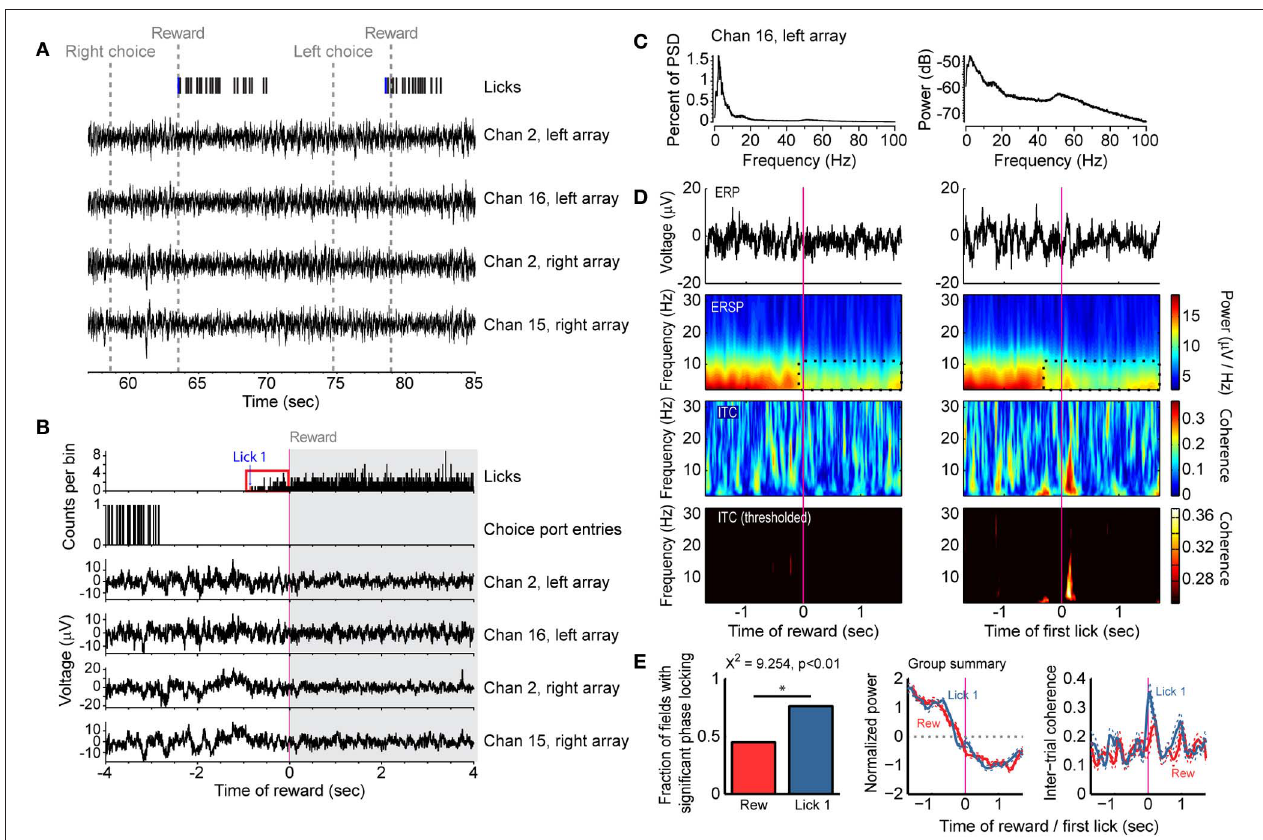
FIGURE 3 | Reward- and consumption-related modulations of field potentials in the delayed alternation task. (A) Example of task events and field potentials over two trials. Four field potentials are shown and the first lick accompanying the reward epoch (“Lick 1”) is designated by a blue tick mark. (B) Histograms for licks and choice port entries and averaged field potentials for the same four recordings as in (A) . Note that rats could lick before receiving reward (red box, allowing for dissociating licking from reward delivery) and that the field potentials showed reduced fluctuations during licking. (C) Power spectral density is shown for one field potential from ( A and B ), plotted as percent of total power (left) and using a log scale (right). (D) Field potentials showed increased power and phase locking around initiation of licking compared to the receipt of reward. Averaged event-related potentials (ERP) are shown in the top row. Event-related spectral power (ERSP) is shown in the second row, and a